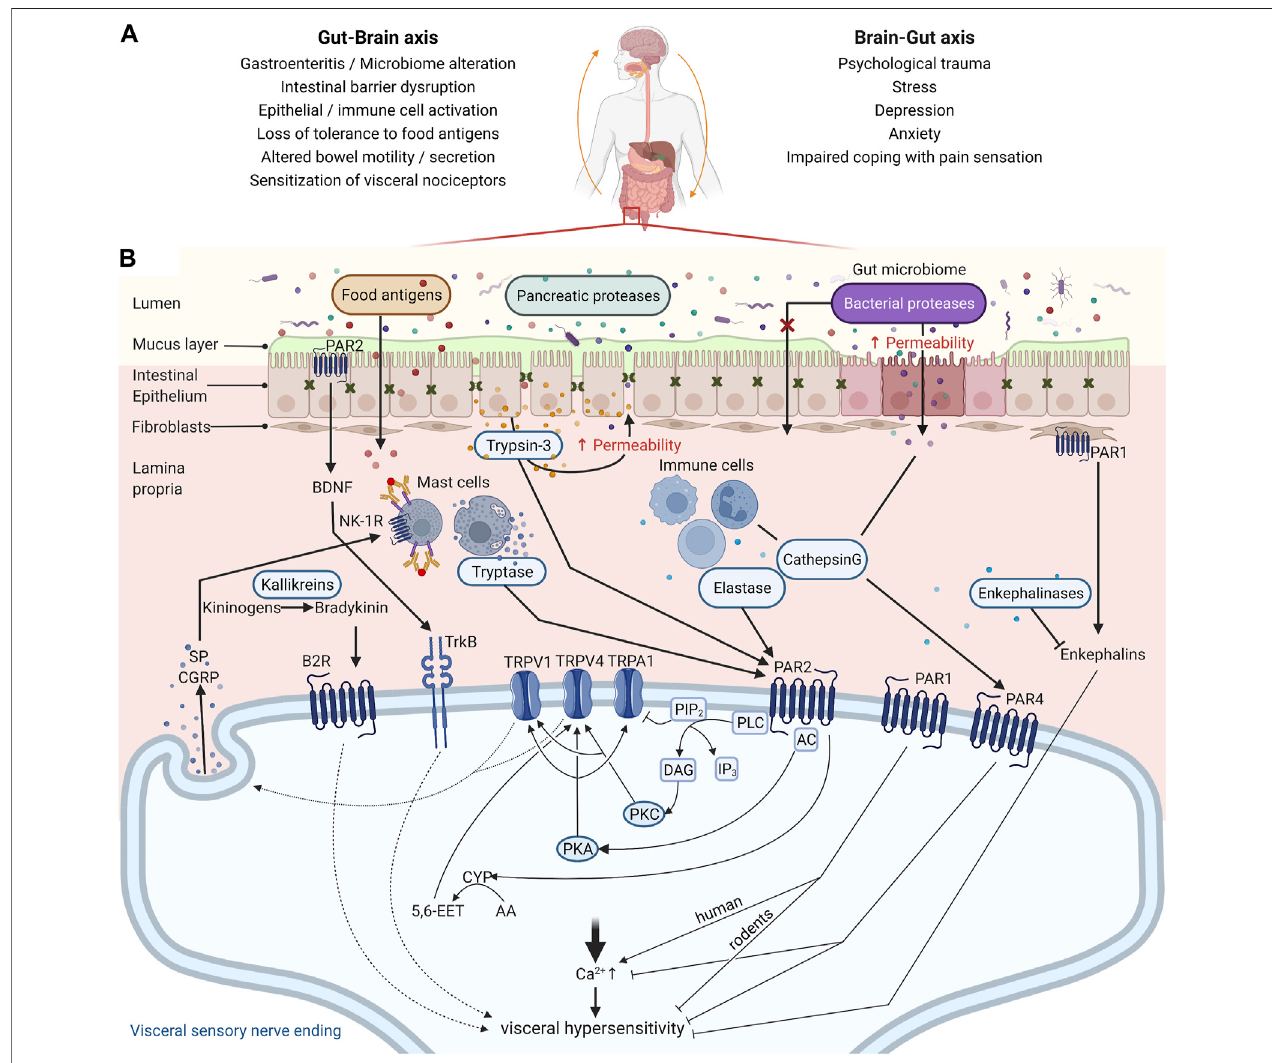
FIGURE 1 | Mechanisms contributing to abdominal pain associated with irritable bowel syndrome (IBS). (A) The pathophysiology of IBS is tightly associated with perturbations in the Gut-Brain Axis, which encompasses a bi-directional communication between these organs. Increasing reports indicate that gastroenteritis may promote intestinal barrier disruption, activation of epithelial and immune cells in the gut mucosa, and loss of tolerance to dietary antigens. Upon re-exposure to those dietary antigens, mast cells degranulate and their mediators sensitize nociceptors leading to visceral hypersensitivity. Conversely, IBS is also associated with a higherprevalenceofpsychiatricdisorderssuchasdepressionandanxiety,factorsthataffectcopingwithpainsensation.Ahistoryofpsychologicaltraumaandstressare also risk factors for IBS, although the mechanisms involved remain unclear. (B) Peripheral sensitization of the gut innervation is a central mechanism underlying abdominal pain in IBS, and proteases are emerging as central mediators in this process. Proteases from the lumen (pancreatic or microbial), epithelial cells (trypsin-3), and immune cells (tryptase, elastase, and cathepsin (G) participate in the disruption of the intestinal barrier and can signal to visceral nociceptors and mediate VHS via protease-activated receptor (PAR) activation. PAR2 activation on the nerve endings of visceral nociceptors induces VHS through TRPV1, TRPV4, and/or TRPA1 sensitization after G ɑ s or G ɑ q recruitment, depending on the protease. TRPV1 and TRPV4 on sensory neurons also mediate the release of substance P (SP) and Calcitonin gene-related peptide (CGRP), further contributing to the pain signal. Additionally, proteases modulate synthesis and secretion of respectively bradykinin and brain-derivedneurotrophicfactor(BDNF),compoundsfoundtobeinvolvedinin fl ammatorypain.Ontheotherhand,activationofPAR1andPAR4hasananalgesiceffect in mice, while in humans PAR1 is emerging as pro-nociceptive. For PAR4 this is likely mediated through reducing intracellular calcium levels. Whether PAR1 mediates VHSduetoactivationofthereceptorinthesensorynerveendingsor fi broblastsremainstobeinvestigatedinanimalmodelsofIBSandpatientsamples.Unliketheother PARs, PAR3 seems to rather act as a cofactor for PAR1 and PAR4 signaling by potentiating the cleavage by proteases like thrombin, but its role still warrants further investigation. Transient Receptor Potential Cation Channel Subfamily V Member 1 (TRPV1) and 4 (TRPV4); Transient Receptor Potential Cation Channel Subfamily A Member1(TRPA1);AdenylylCyclase(AC);ProteinKinaseA(PKA);PhospholipaseC(PLC);ProteinKinaseC(PKC);CytochromeP450Epoxygenase(CYP);Arachidonic Acid (AA); 5,6-epoxy-8Z,11Z, 14Z-eicosatrienoic acid (5,6-EET); Neurokinin-1 Receptor (NK1-R); Bradykinin Receptor B2 (B2R); Neurotrophic Receptor Tyrosine Kinase 2 (TrkB); Phosphatidylinositol 4,5-bisphosphate (PIP2); Inositol 1,4,5-trisphosphate (IP3); Diacyl Glycerol (DAG). Created with BioRender.com.